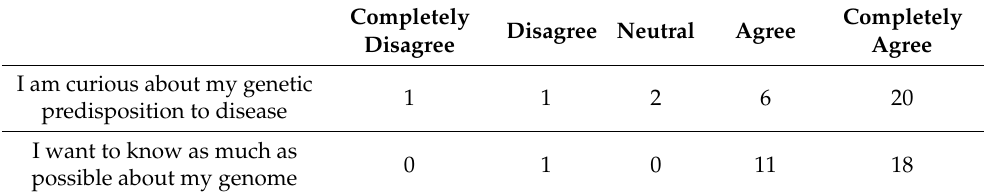
Table 4. Respondents’ attitudes towards receiving hypothetical WGS results (pre, n = 30).